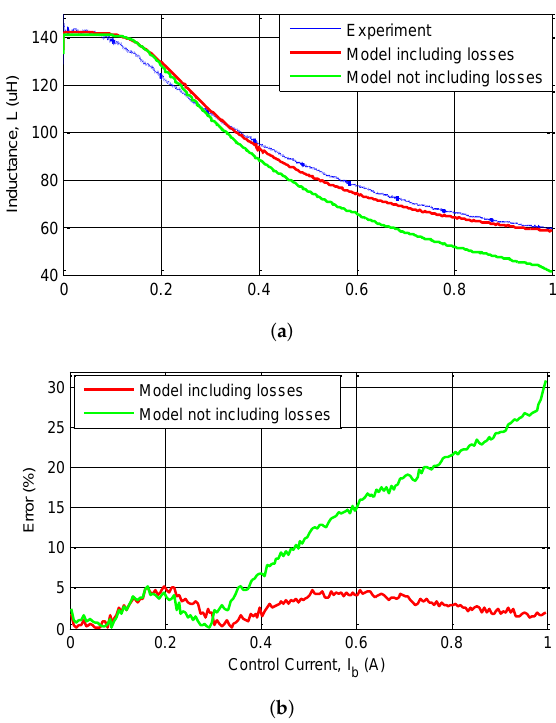
Figure 17. Large-signal characterization of the variable inductor prototype comparing simulation models with experimental results. ( a ) Inductance value, and ( b ) percentage error as a function of control